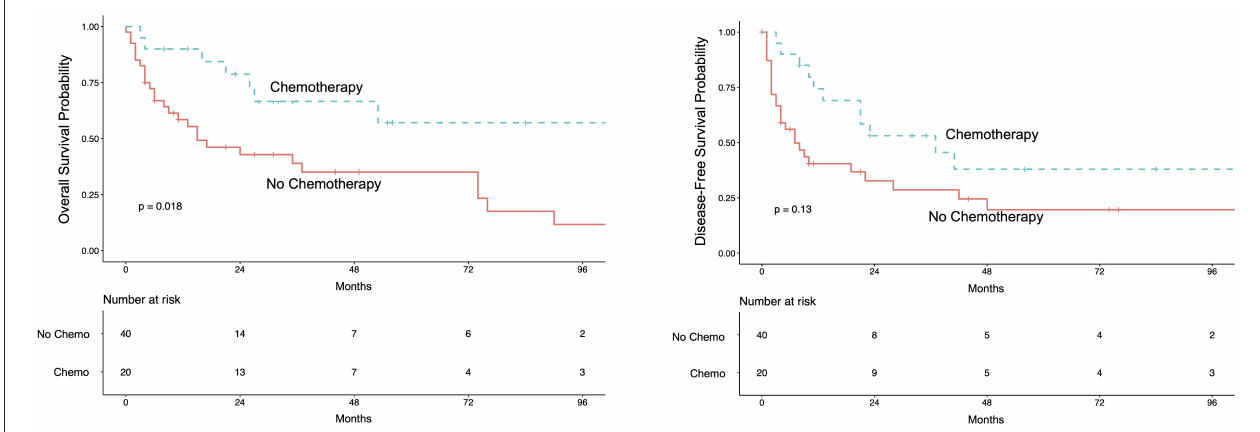
FIGURE 2 | Kaplan-Meier curve for overall survival (left) and disease-free survival (right) for the matched pair analysis for patients receiving adjuvant chemotherapy. Patients were matched in ratio 1 treated to 2 controls for post-operative tumor stage ( < pT3; ≥ pT3; pN + ) and age. In the adjuvant chemotherapy-group 11 patients received Gemcitabine/Cisplatin; 4 patients received Gemcitabine/Carboplatin; 5 patients received other